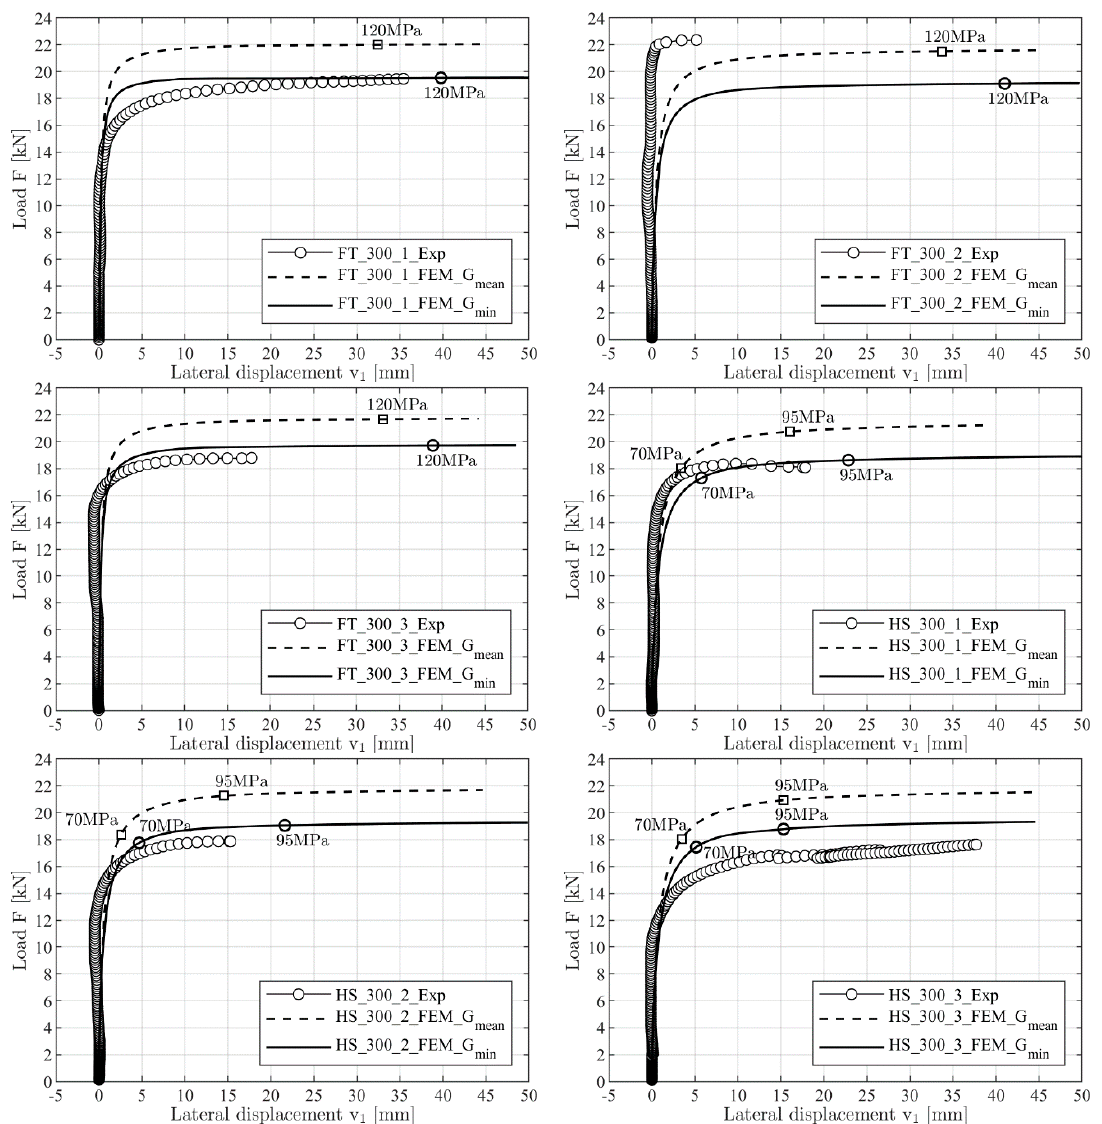
Figure 7. Experimental and numerical load-deflection curves (values obtained at the free end of the cantilever beam) from test specimens with a glass-height of 300 mm.